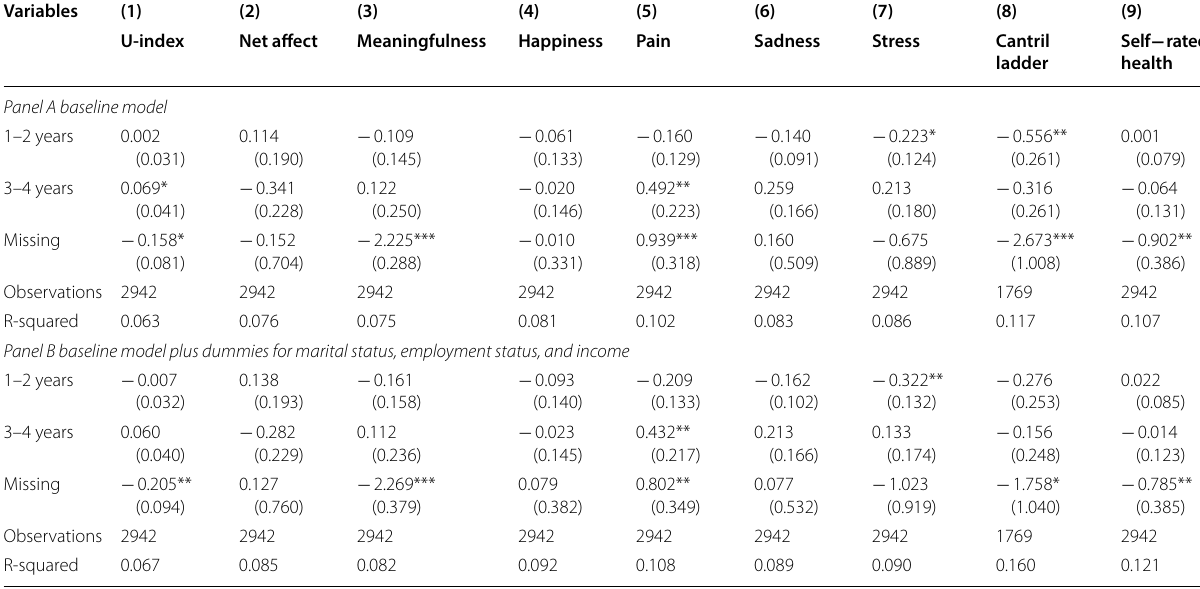
The estimates in columns 1 through 7 and 9 are OLS coefficients from the 2010, 2012, and 2013 ATUS WB Modules; the estimates in column 8 are OLS coefficients from the 2012 and 2013 ATUS WB Modules. All estimates use the WB Module final weight (WUFINLWGT). Standard errors in parentheses. *** p < 0.01, ** p < 0.05, * p < 0.1. The following control variables are included in all columns in both Panels A and B: age and its square; three dummies for race/ethnicity; five education dummies; number of disabilities; an immigrant dummy; number of children; a metropolitan status dummy; two season dummies; year dummies; dummies for the DWS year; and state dummies. Columns 1 through 7 additionally contain a holiday dummy and six dummies for the days of the week. Panel B additionally includes two marital-status dummies; two employment-status dummies; and four dummies for family income during the last 12